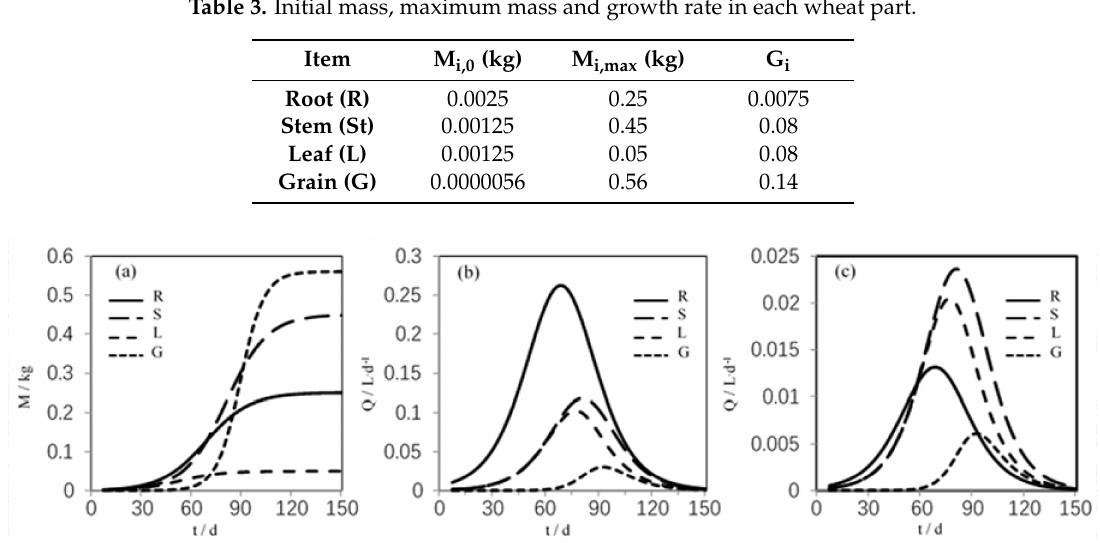
Figure 4. Changes in mass and flux over time in the wheat growth process. ( a ) Mass; ( b ) Flux (down-up); ( c ) Flux